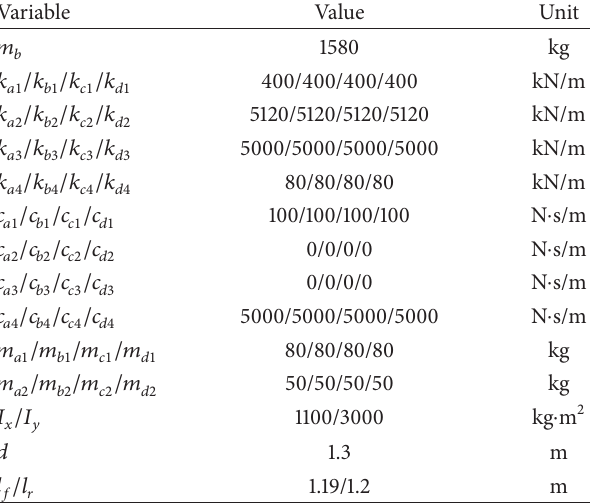
Table 1: Parameters of the